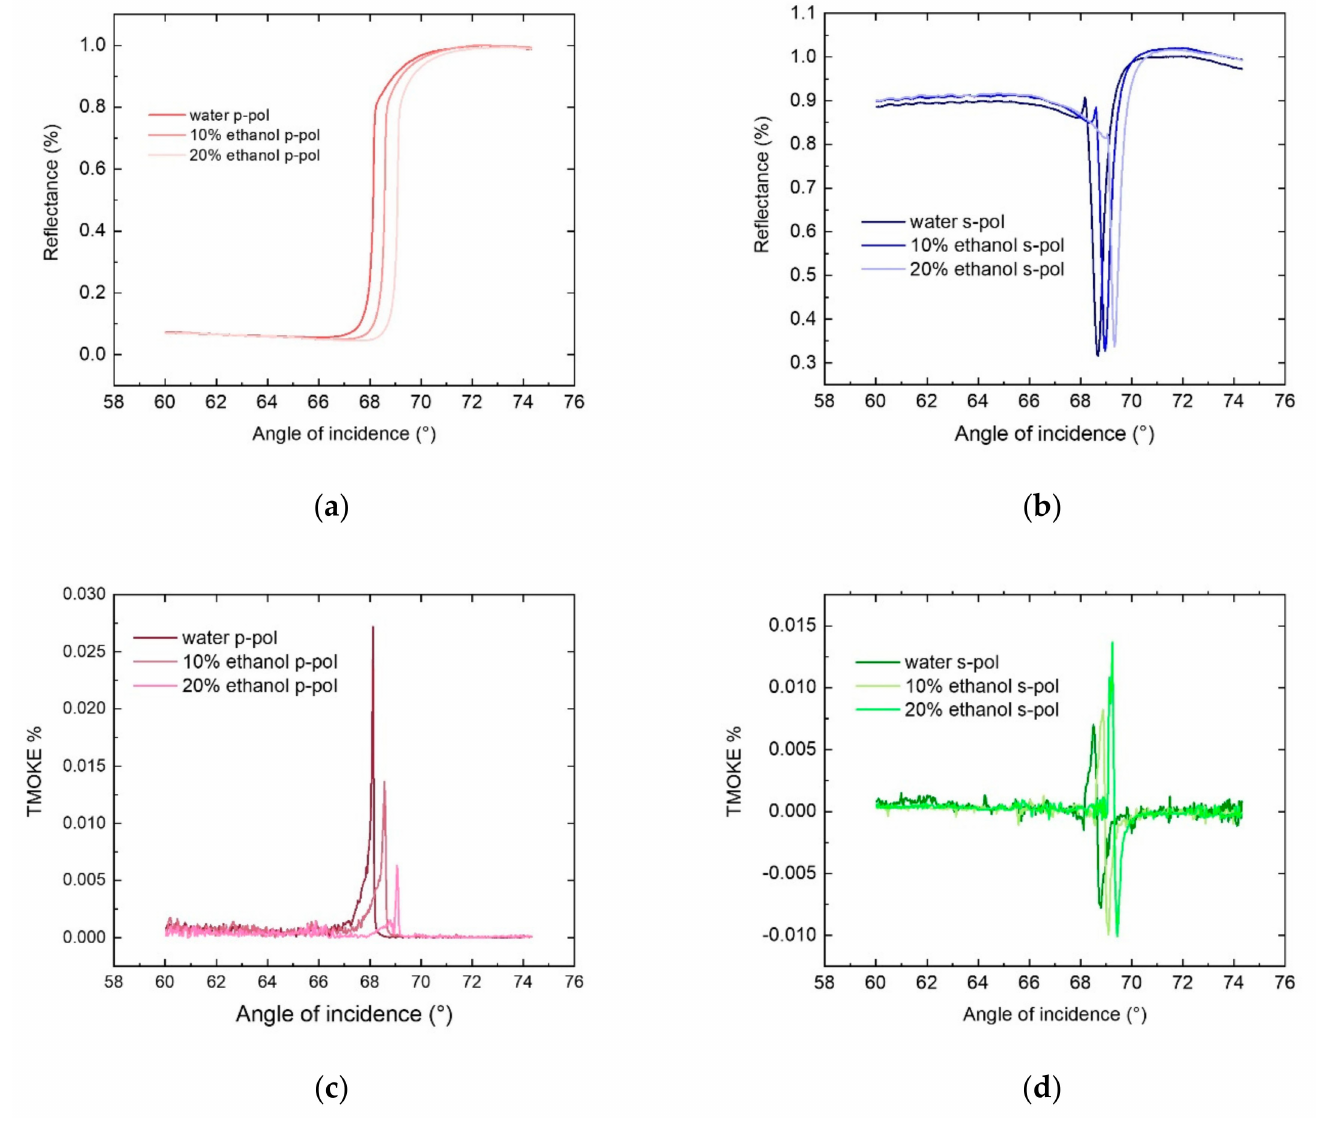
Figure 3. The reflectance ( a , b ) and magneto-optical ( c , d ) angular spectra of the magnetophotonic crystal in ( a , c ) p- and ( b , d ) s-polarizations of the incident light measured for different concentrations of the